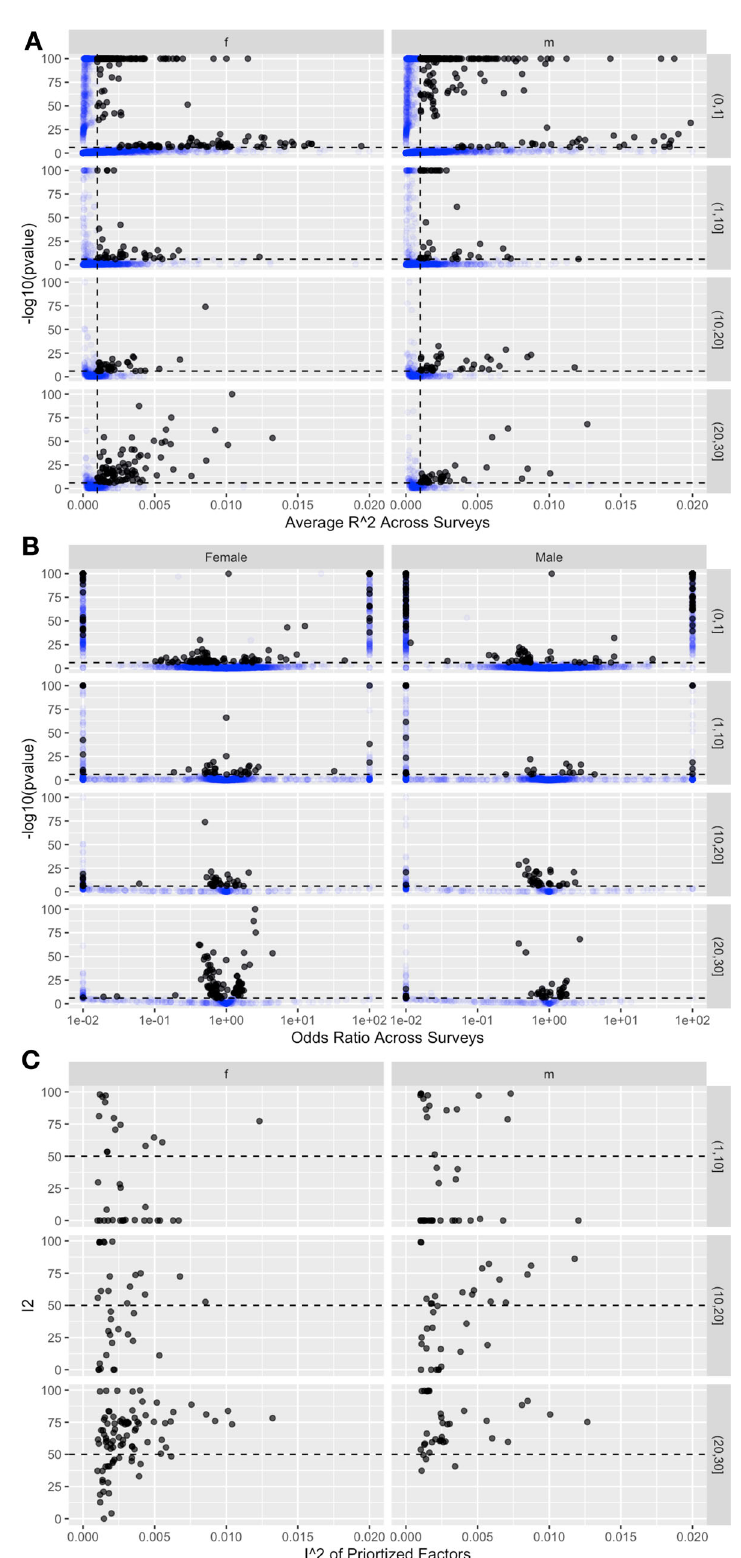
Fig. 1 Volcano plots of -log10( p value) versus R 2 and Odds Ratios. A Nagelkerke R 2 ( B ) Odds Ratios ( C ) Heterogeneity I 2 of identi fi ed variables across all surveys. OR capped at 0.01 and 100 for visualization purposes. In A and B , Dotted line denotes Bonferroni-level of signi fi cance (1 x 10 − 6 ). In C , dotted line corresponds to I 2 of 50%. f females. m